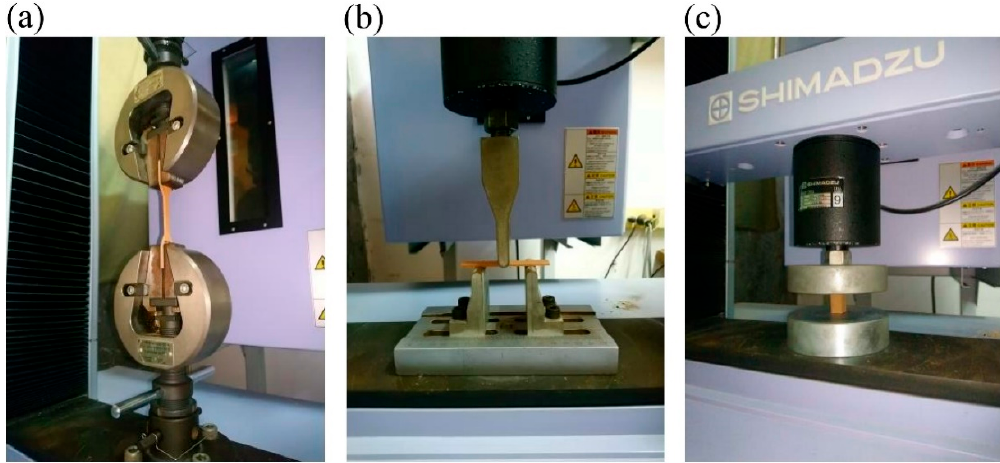
Figure 3. Setups of the tensile test ( a ), flexural test ( b ), and compressive test ( c ).